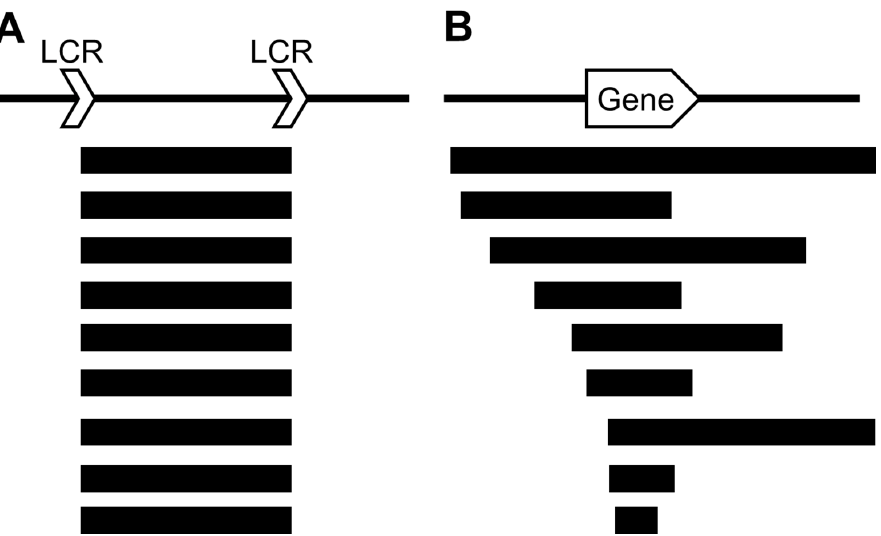
Figure 2. Schematic representation of the patterns of deletions. ( A ) Deletions (black rectangles) caused by nonallelic homologous recombination triggered by surrounding LCRs show the same breakpoints in patients. ( B ) Deletions (black rectangles) with random breakpoints, however, include specific gene(s).